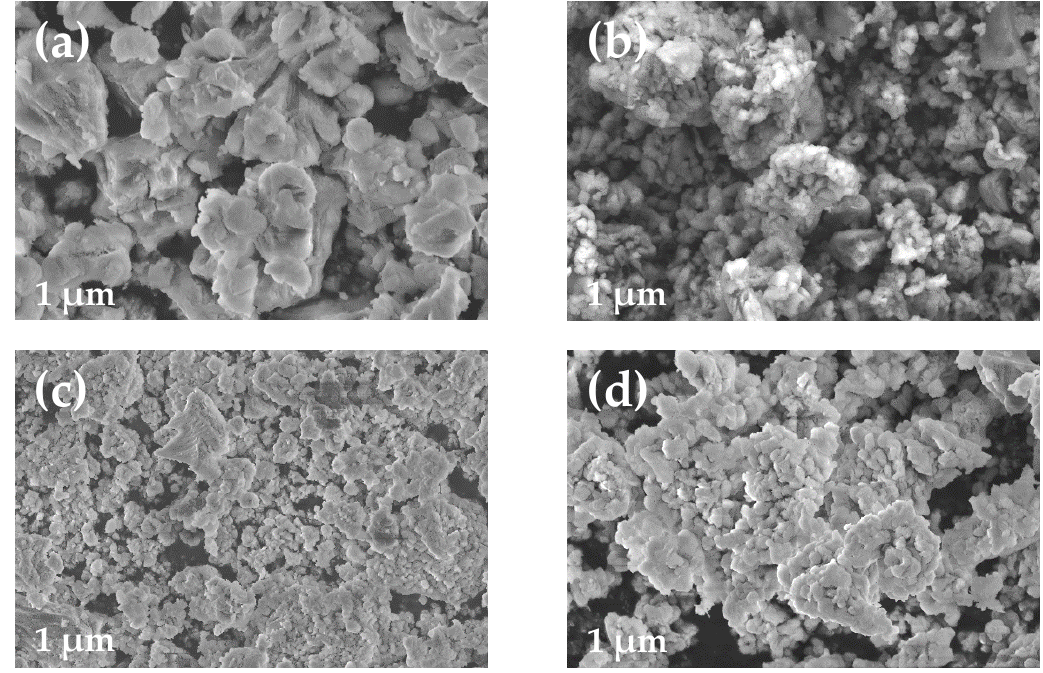
◦ C, ( c ) CaO 600 ◦ C, ( d ) CaO 700 ◦